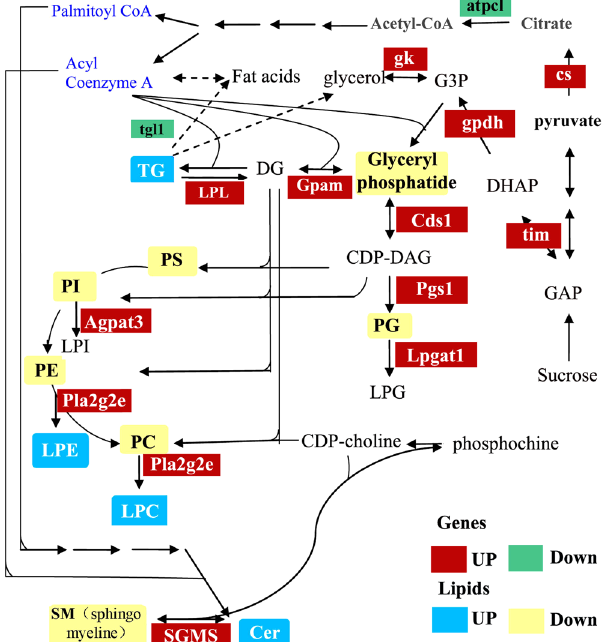
Figure 7. Glycerophospholipid metabolism is induced in parasitized A . gossypii . Pathway of select glycerophospholipid metabolites from the KEGG database with indications of quantified lipid classes and genes significantly regulated in parasitized aphids. Red and green colored boxes indicate increased and decreased expression levels of genes in parasitized aphids, respectively. Yellow boxes indicate decreased lipid classes and blue boxes indicate high expression of glycerophospholipids. In the fat synthesis pathway, acetyl CoA is an intermediate between the TCA cycle and the fat synthesis pathway. Besides, G3P is the intermediate between glycolysis and the fat synthesis pathway. TAGs are produced by G3P and acyl-coenzyme A; while G3P is converted to glyceraldehyde 3-phosphate (GAP) via glycolysis, and acyl CoA is converted to palmityl coenzyme A and acyl-coenzyme A. Some genes in the glycolytic pathway and TCA cycle that are believed to stimulate the phospholipid metabolic pathways are also shown. DHAP , dihydroxyacetone phosphate; Lpgat1 , lysophosphatidylglycerol acyltransferase 1; gk , glycerol